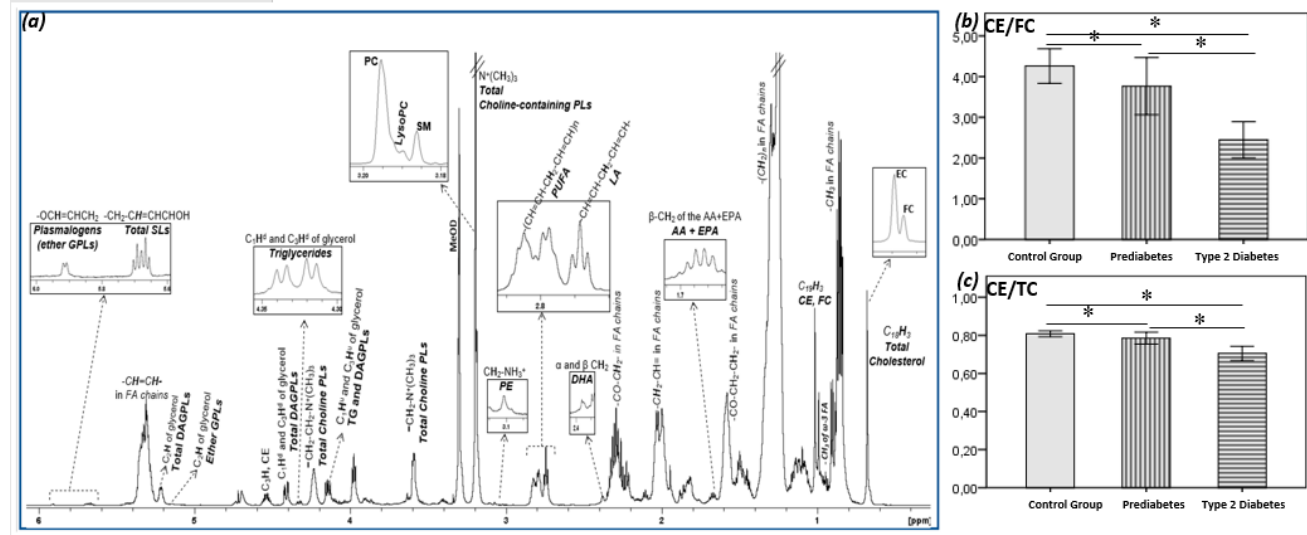
Figure 1. ( a ) 1 H NMR spectrum of an HDL lipid extract. Figure adopted from [14], ( b ) Cholesterol esters to free cholesterol (CE/FC) ratio in the study groups (mean ± SD), ( c ) cholesterol esters to total cholesterol ratio (CE/TC) in the study groups (mean ± SD). * Statistically significant ( p < 0.001). Total HDL surface lipids expressed as the sum of FC and total phospholipids (PLs) Table 3. Phospholipid profiling of HDL lipoproteins. was lower in prediabetes due to the significantly lower percentage of total PLs (GPLs, ether GLs, SLs), which was further decreased in T2D resulting in a significant and gradual increase of TC/PLs ratio (Table 2).